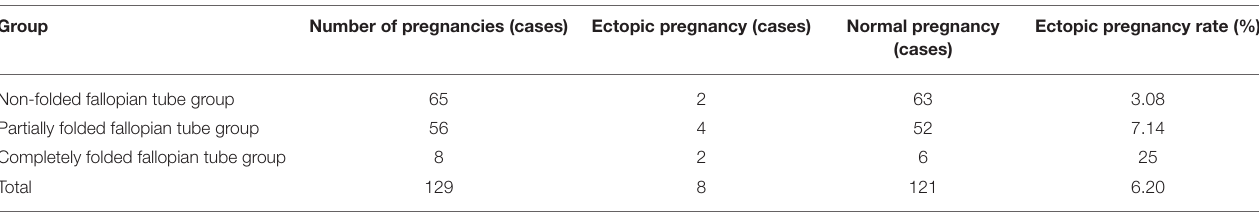
TABLE 6 | Fallopian tube distortion and ectopic pregnancy. Group Number of pregnancies (cases) Ectopic pregnancy